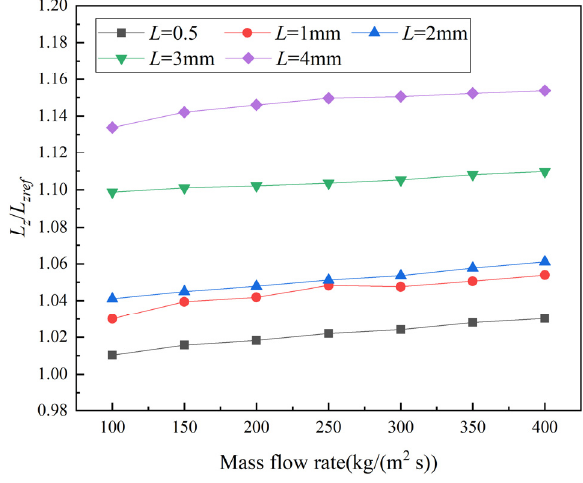
Figure 16. The ratios of the total length of the PCHE with different offset distances of inserted straight sections to the total length of the Z-shaped PCHE at different mass flow rates.